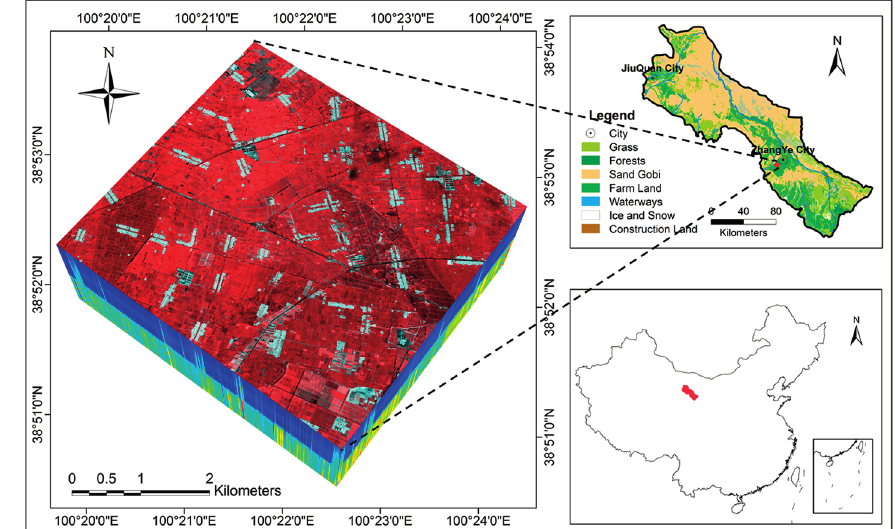
Figure 1. The study area, a cultivation base in the middle reaches of the Heihe River, Gansu Province, China, is approximately 8 km southwest of Zhangye City. The hyperspectral cube was obtained from airborne CASI, and the remote sensing image on top of the cube is a false color composition of three hyperspectral imagery bands (R: band centered at 826 nm, G: band centered at 683 nm, B: band centered at 540